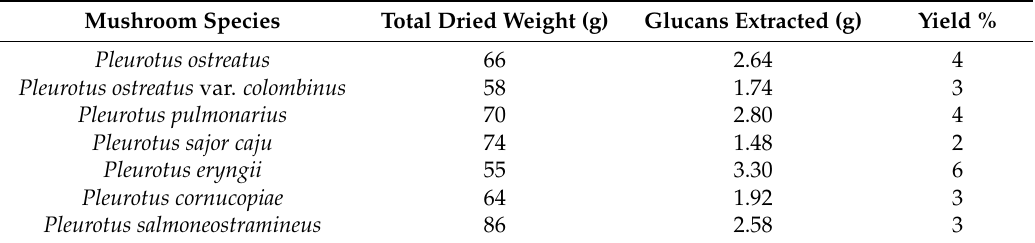
Table 1. Calculated yield extraction of total glucans/dry matter, for different mushroom strains. Mushroom Species Total Dried Weight (g) Glucans Extracted (g) Yield % Pleurotus ostreatus 66 2.64 4 Pleurotus ostreatus var. colombinus 58 1.74 70